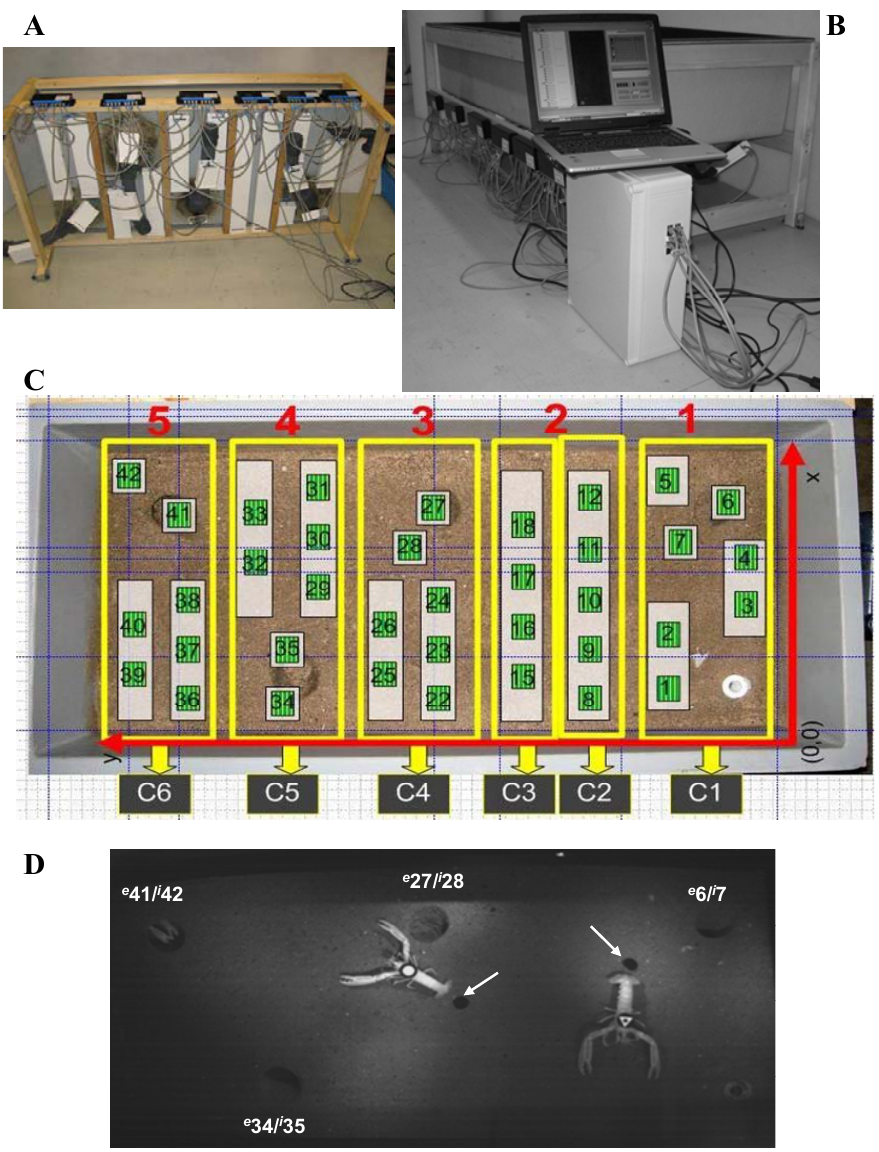
Figure 1. Details of the RFID system used to monitor the behaviour of a group of Nephrops held in a laboratory microcosm tank. (A) Details of the antenna network (the large white plates) mounted below the microcosm tank, including those placed on the tunnels (the small white plates on the grey tubes). (B) A side view of the tank showing the laptop used to acquire the RFID data from the controllers. (C) An upper view of the tank superimposed with the scheme depicting the antenna positioning (green squares numbered from 1 to 42); the antenna relationship with the controllers (from C1 to 6), covering five different areas (from 1 to 5) of the tank; and the x , y reference coordinates used to compute the animals’ displacement in centimetres. (D) A video camera field of view encompassing the whole tank surface, where the following objects are visible: the four burrows indicated by their antennas (numbers) placed inside ( i = inside) or at the entrance ( e = entrance); two fully emerged and one partially sheltered animal dragging their black circular RFID transponders, indicated by the white arrows; and finally, the geometric tags used for the automated video